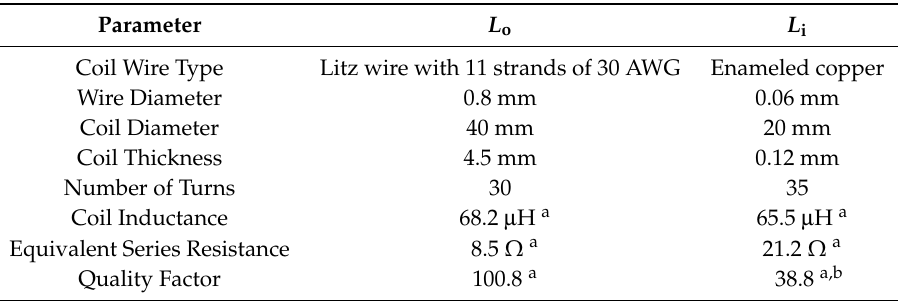
Table 1. Parameters of The